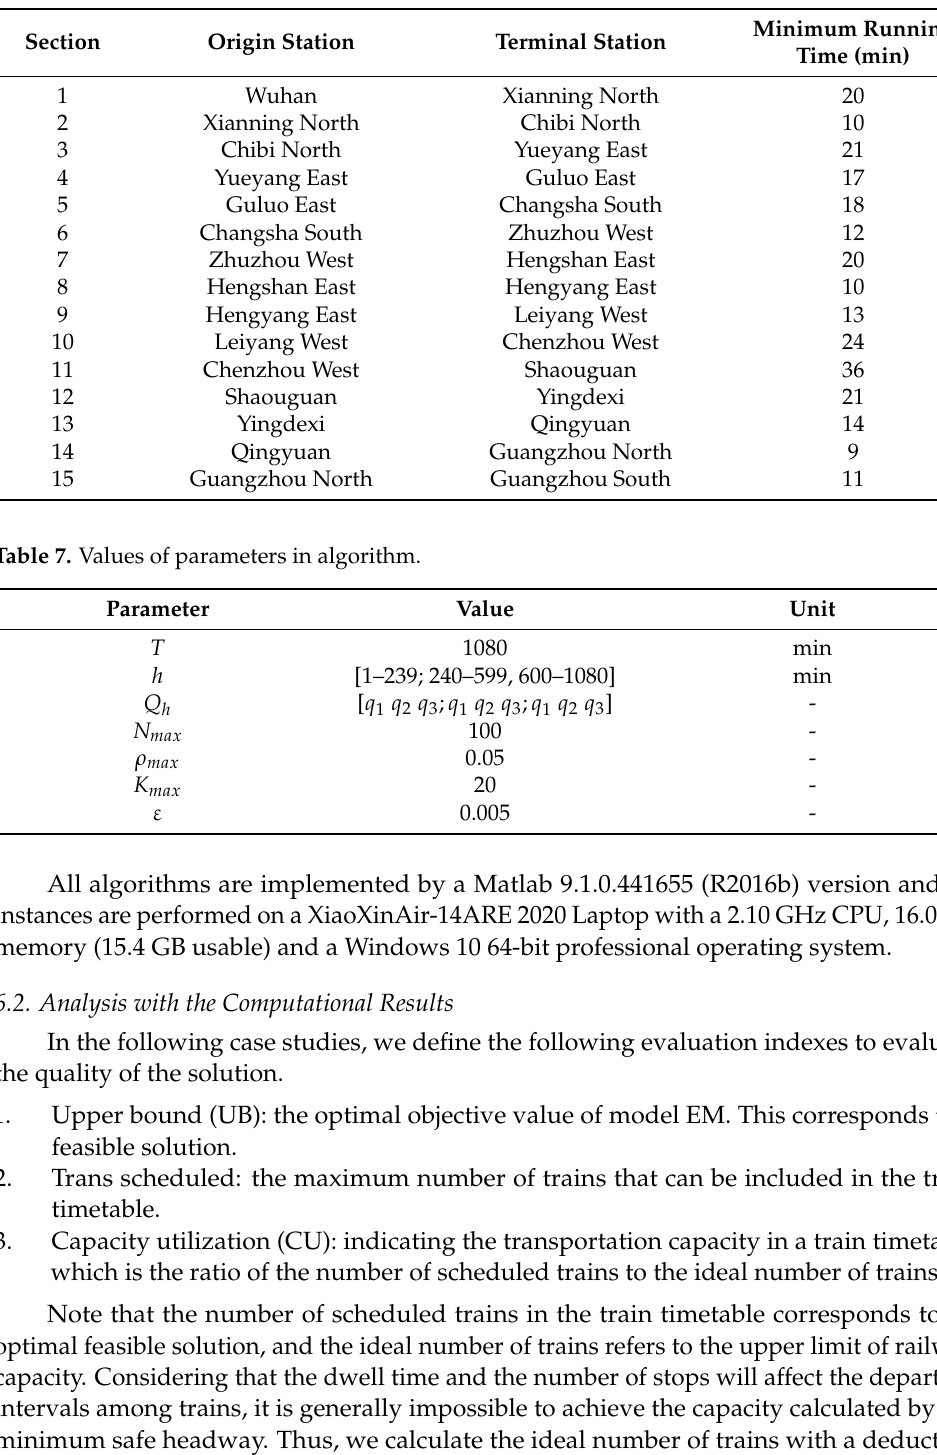
Table 6. The minimum running times.